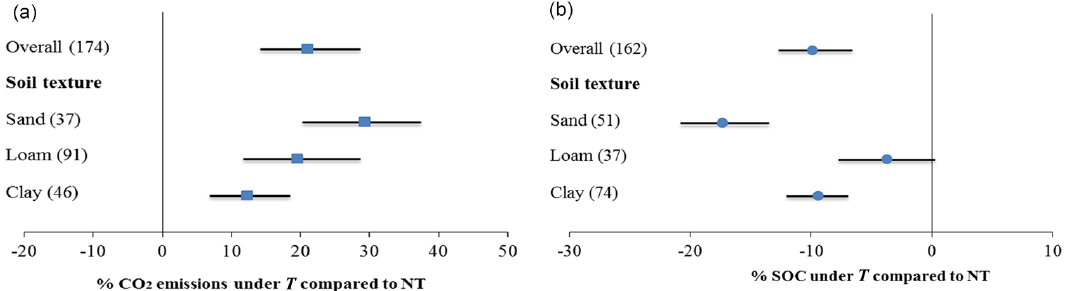
Figure 3. Percent change in (a) soil CO 2 emissions and (b) SOC in tillage ( T ) soil compared to no-tillage (NT) as a function of soil particle distribution (clay, loam and sand). The numbers in the parentheses indicate the direct comparisons of the meta-analysis. Error bars are 95% confidence intervals.